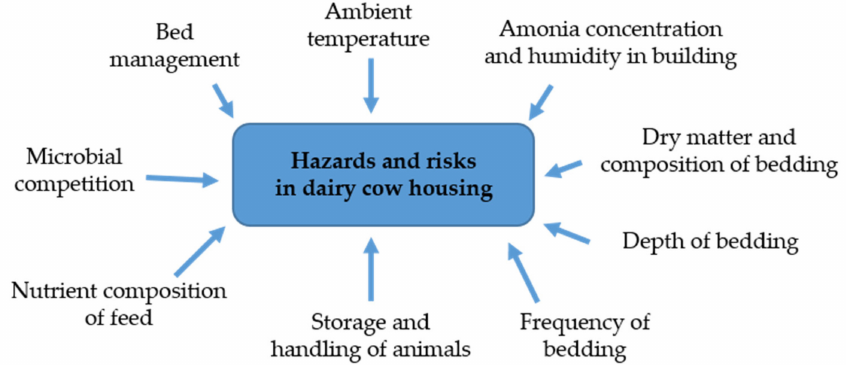
Figure 1. Factors a ff ecting hazards and risks associated with bedding materials in dairy cow housing. Sources: modified figure according to Bradley et al.